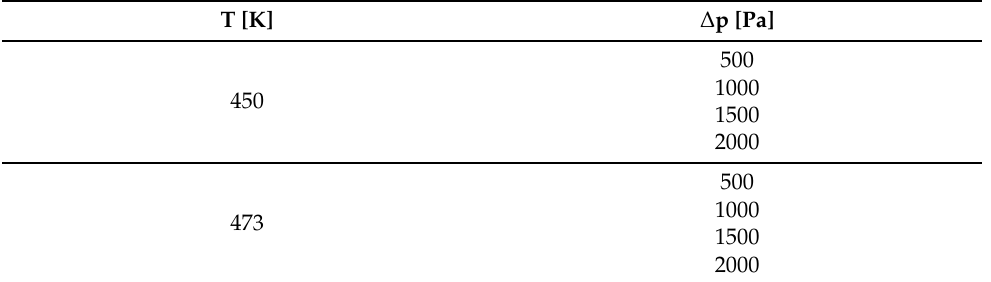
Table 3. Microscale model: case definitions.